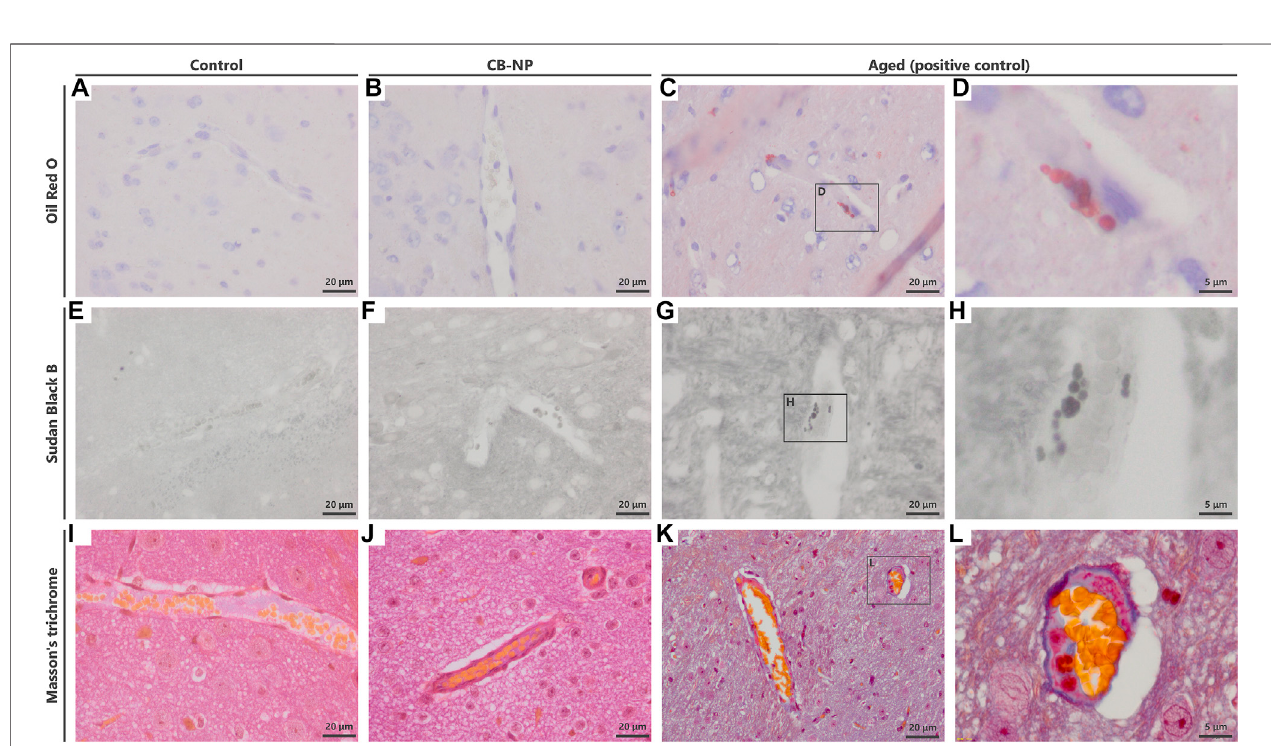
FIGURE 3 | Detection of histopathological changes in perivascular macrophages (PVMs). To detect the denaturation of PVMs, Oil Red O staining, Sudan Black B staining, and Masson ’ s trichrome staining were performed. (A – D) Light micrographs of brain sections stained with Oil Red O. Blue and red indicate the nucleus and accumulation of lipid, respectively. (E – H) Light micrographs of brain sections stained with Sudan Black B. (I – L) Light micrographs of brain sections stained with Masson ’ s trichrome stain. (D,H,L) are enlarged pictures of (C,G,K) , respectively. These staining could stain PVMs with severe denaturation in the brains of aged mice but did not detect mild denaturation of PVMs in the brains of both the control and carbon black nanoparticle exposure groups.